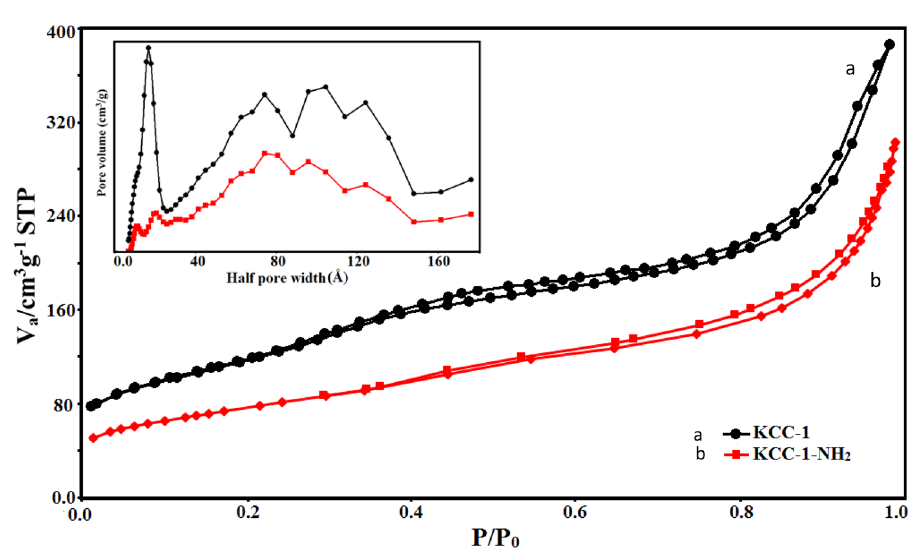
Figure 4. Nitrogen adsorption–desorption of KCC-1 and KCC-1-NH 2 and pore size distribution (inset) of samples utilizing non-local density functional theory (NLDFT) model.